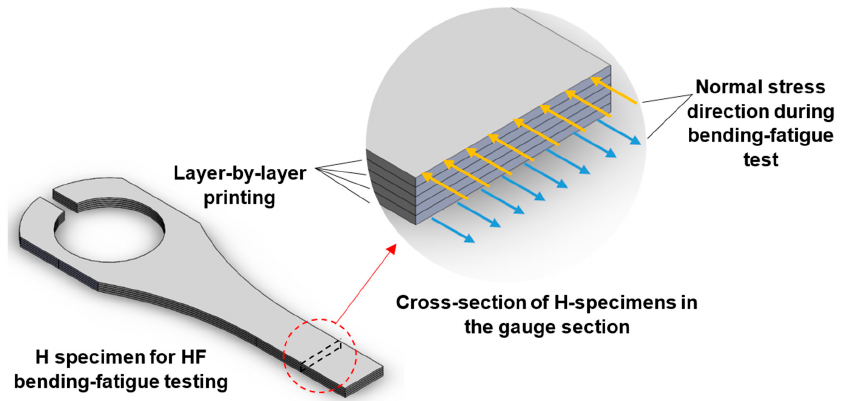
Figure 12. Applied normal stress direction in the cross-section of the H specimens during ultrasonic bending fatigue testing.